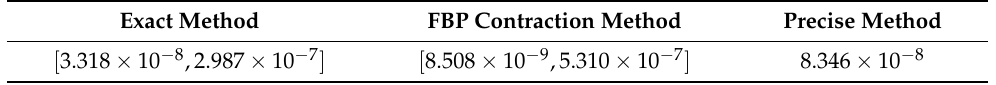
Table 9. The unavailability of the system using different